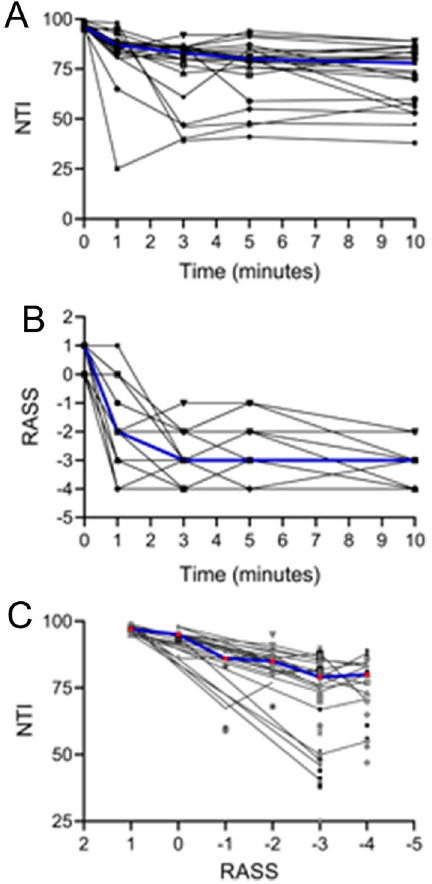
Figure 3. The change in the Narcotrend index (NTI; A ) and Richmond Agitation-Sedation Scale (RASS; B ) at 0, 1, 3, 5, and 10 min after the administration of remimazolam besylate. NTI and the corresponding RASS for each patient ( C ). The blue curve represents the median value.